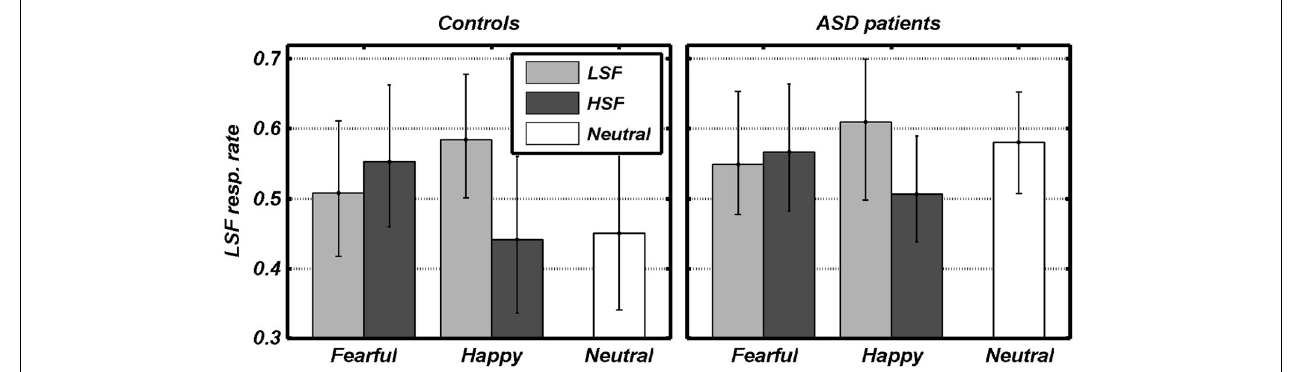
FIGURE 3 | Behavioral data. The rate of gender judgments made according to the LSF information in each condition is plotted against the valence of facial expressions. Dark and light gray bars refer to the different spatial frequencies